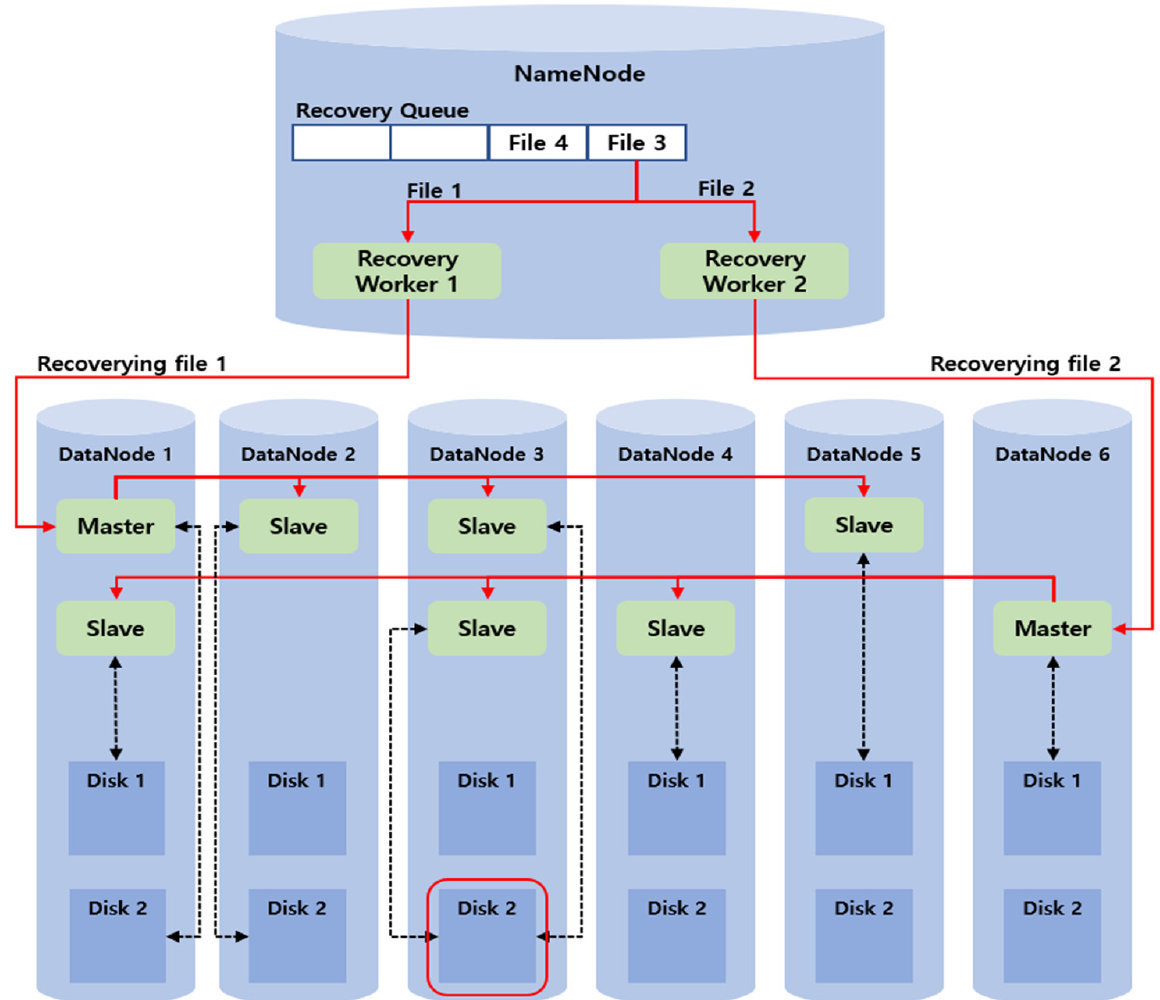
Figure 12. Example of disk loads due to parallel recovery.